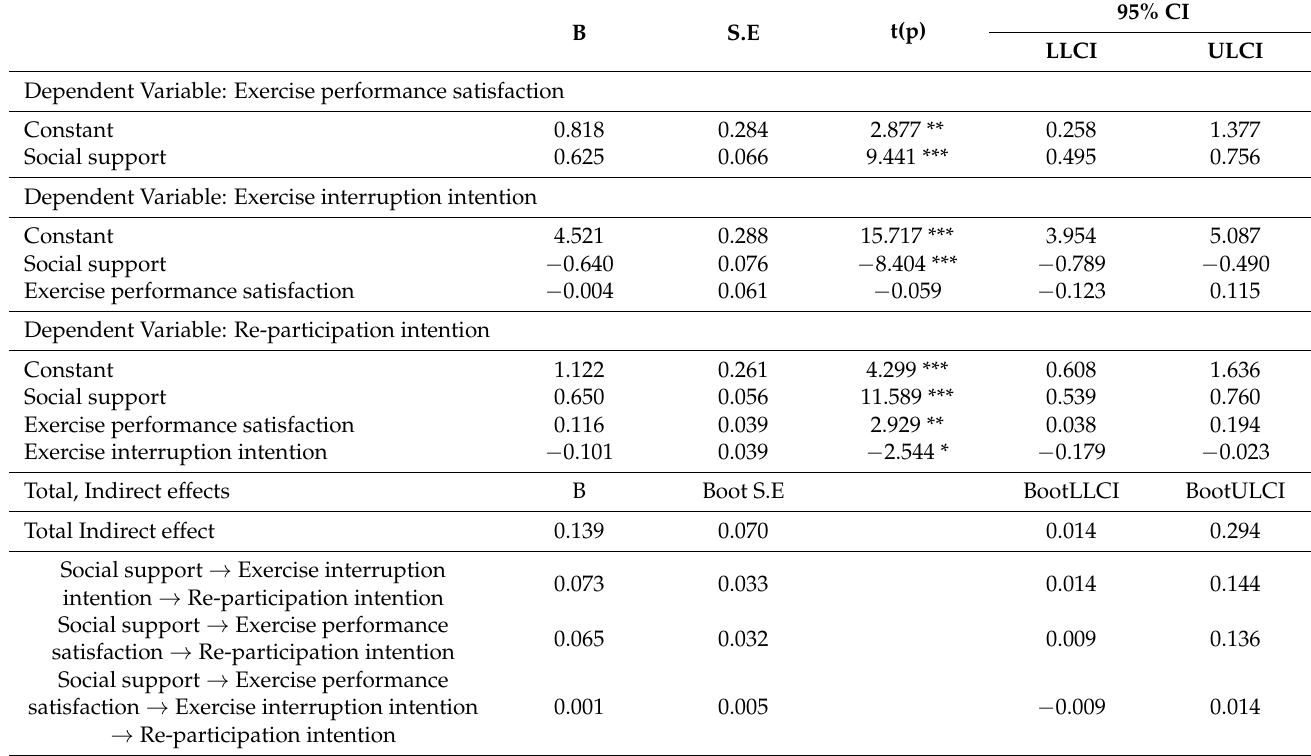
Table 2. Direct and moderated mediating effect